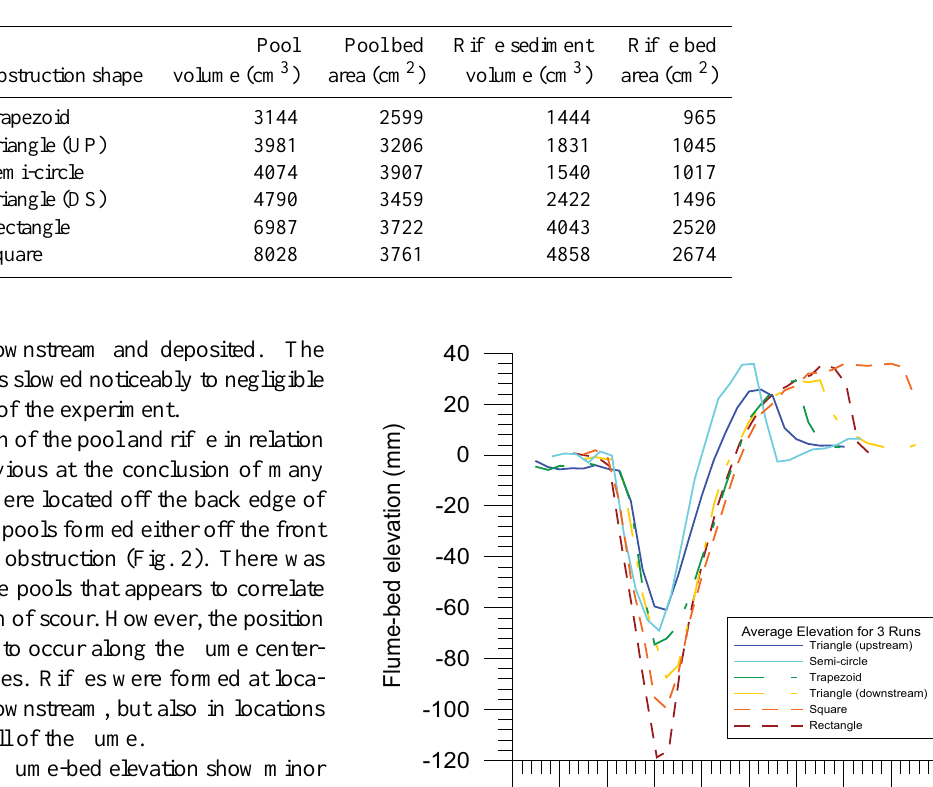
Table 1. Volumes of pool scour and sediment deposited as riffle for the different obstructions.